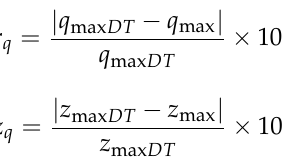
Figure 2. DT-based operation rules.